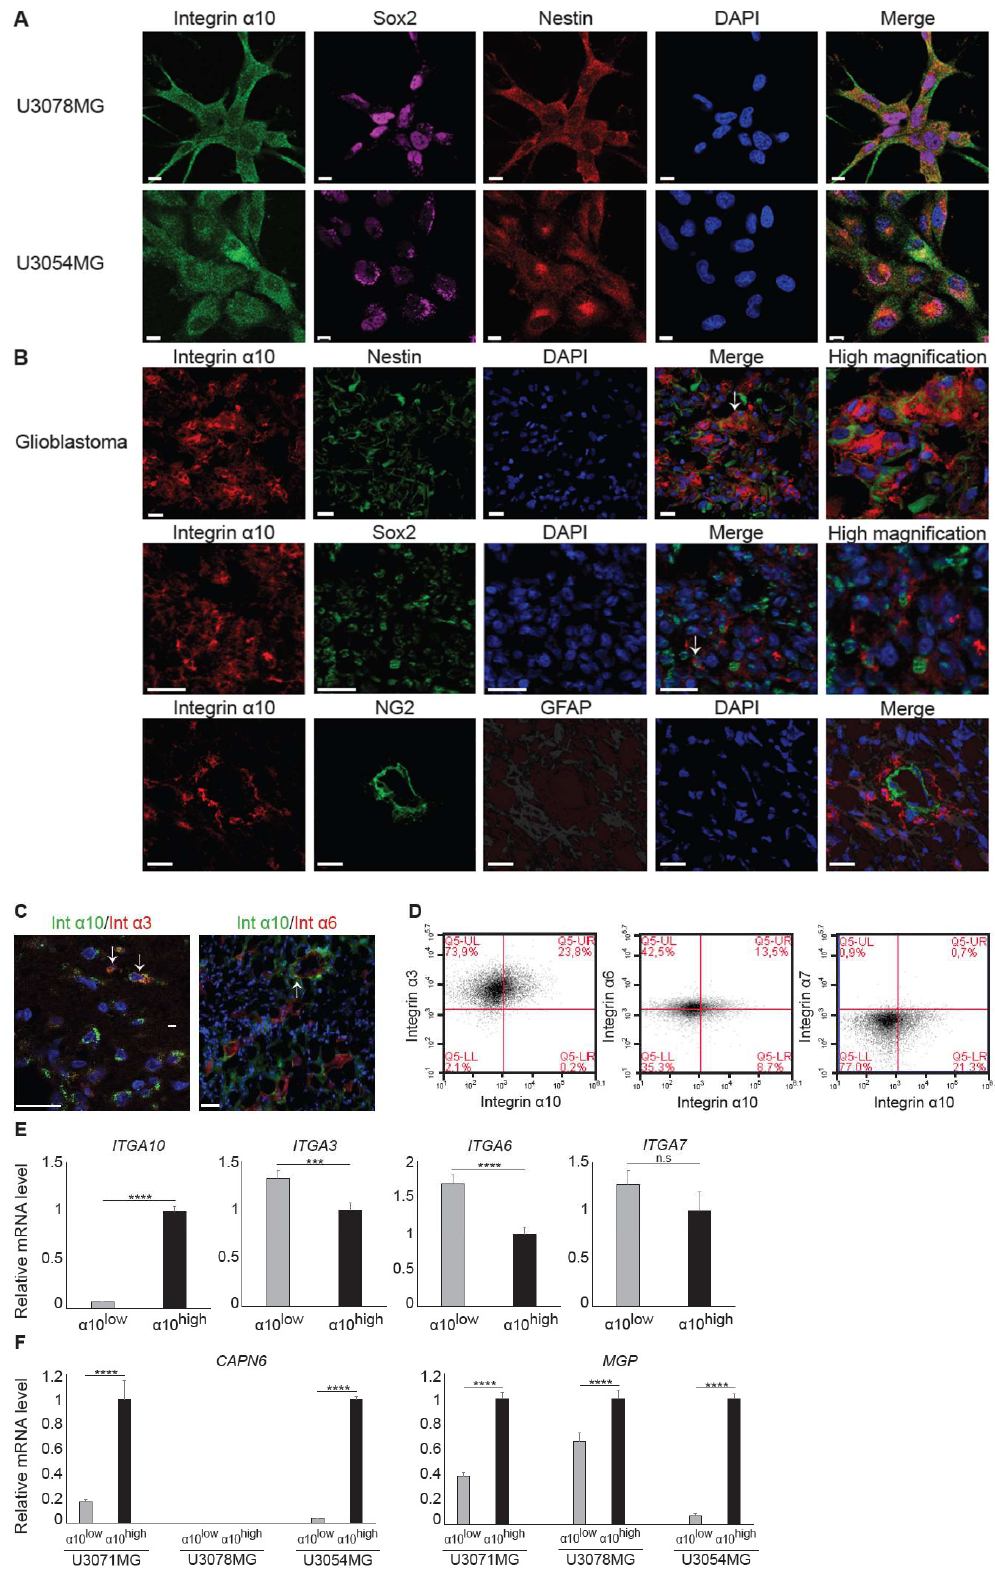
Figure 3. Integrin α 10 high -expressing cells define a subpopulation of GBM cells. ( A ) Representative images of U3078MG and U3054MG GBM cells, triple immunofluorescence labeled for integrin α 10, Sox2, Nestin, DAPI staining of cell nuclei, and a merged image (Merge). Scale bars represent 10 µ